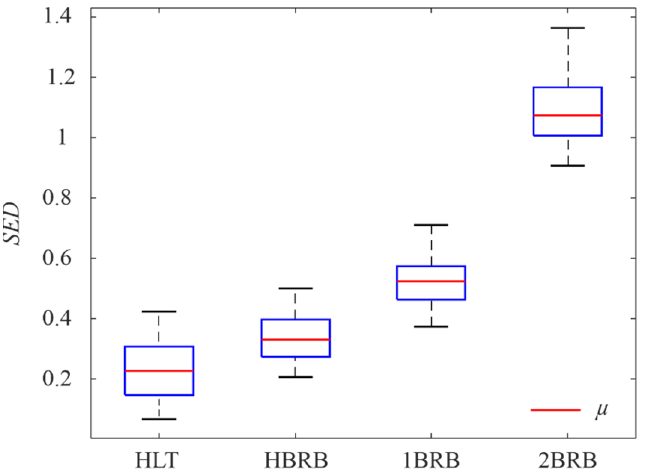
Figure 11. Boxplot for the SED values.